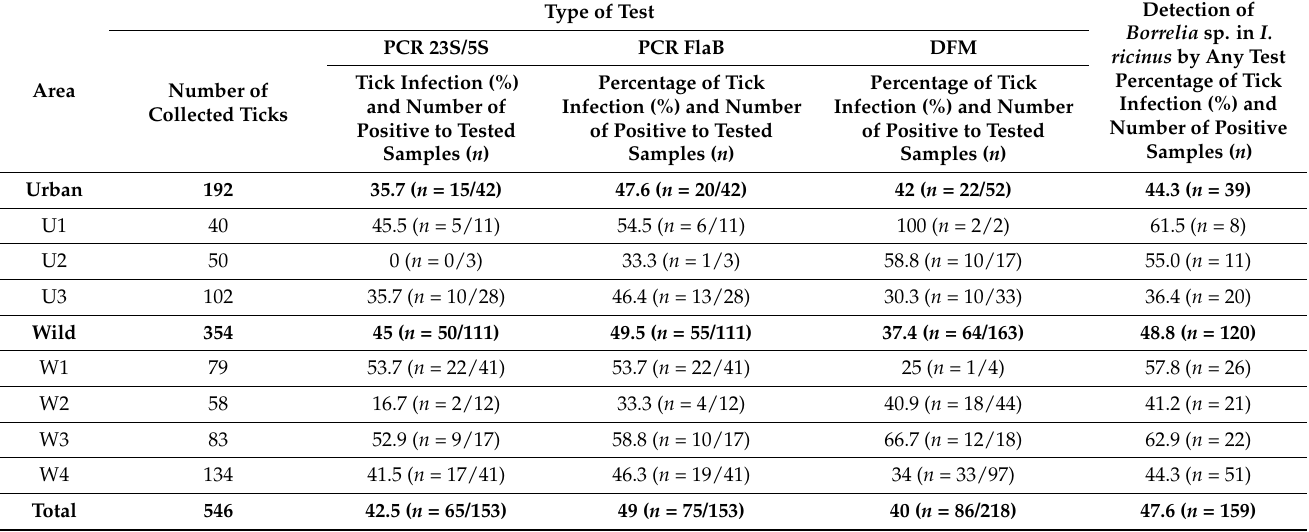
Table 3. Results of Ixodes ricinus testing for the presence of Borrelia burgdorferi s.l. within the Kaylaka Park study